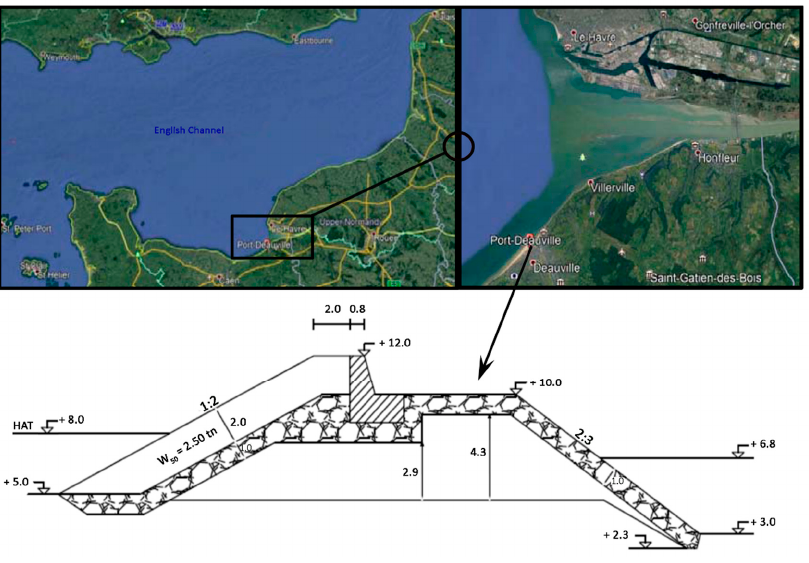
Figure 5. Typical cross-section of the studied rubble mound breakwater in the port of Deauville, Le Le Havre, northern Havre, northern France.